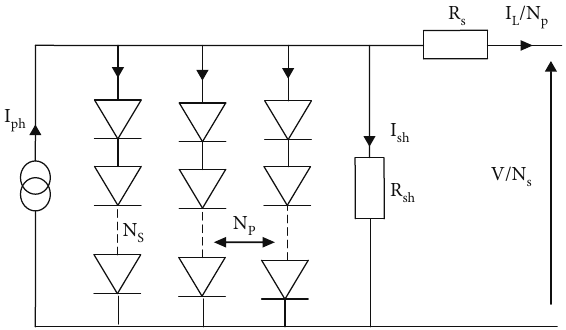
Figure 2: Equivalent model of PV panel.